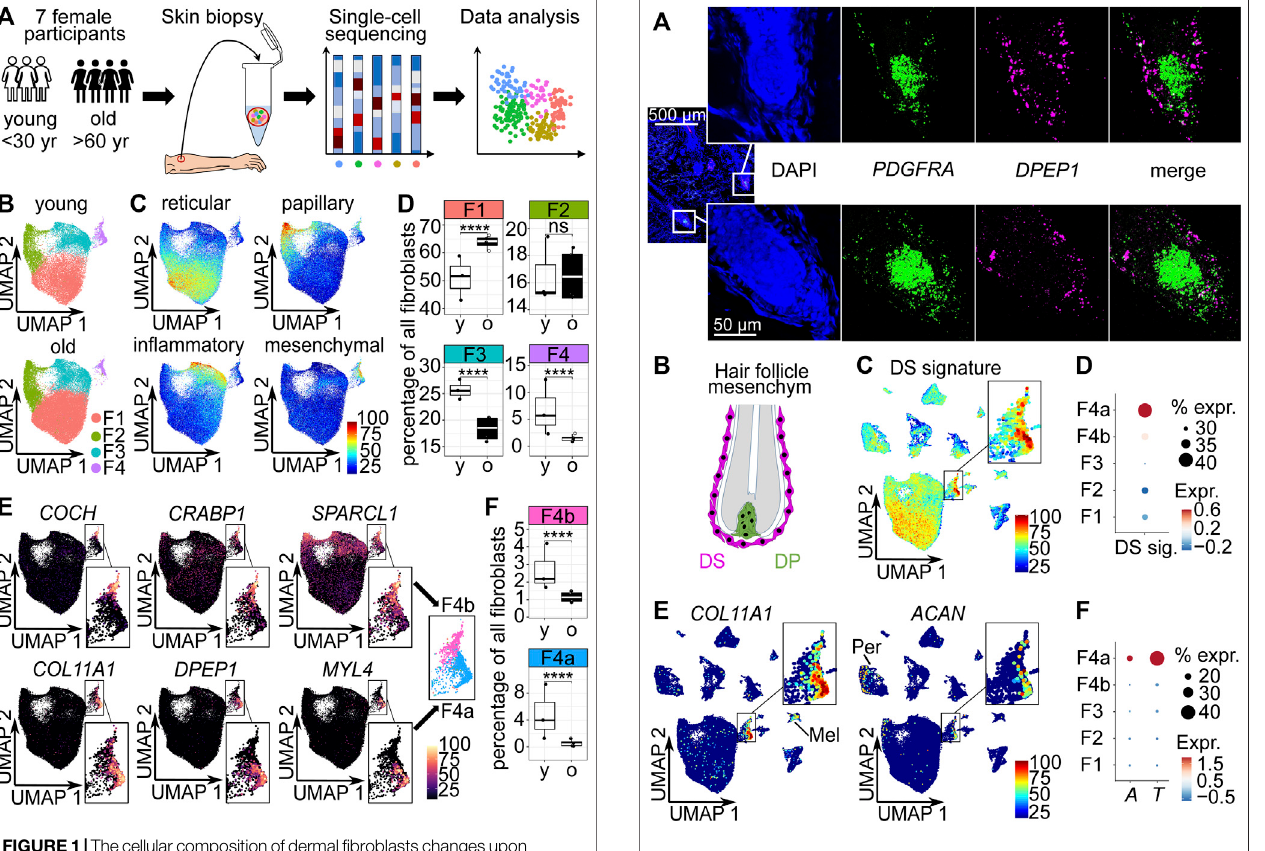
FIGURE 2 | Subpopulation 4a represents the dermal sheath (DS). (A) RNA-FISH co-staining of subpopulation 4a marker DPEP1 with PDGFRA , n (cid:1) 5. (B) Mesoderm-derived cell types of the hair follicle: DS cells, dermal papilla (DP) cells. Average expression of top 10 DS signature genes ( CCDC80 , COL11A1 , TNMD , LRRC15 , COL12A1 , FGL2 , CD200 , FAM101B , SPARC , IGFBP7 ) (Shin et al., 2020) (C) among all cell types in Uniform Manifold Approximation and Projection (UMAP) plot and (D) among fi broblast populations in dot plot. (E) Expression of DS-speci fi c genes COL11A1 and ACAN among all cell types in UMAP plots. (F) Dot plot of theexpression of DS marker genes ACTA2 (A) and TAGLN (T) among fi broblast populations. % expr. Percent expressed, expr. average expression, Mel melanocytes, Per